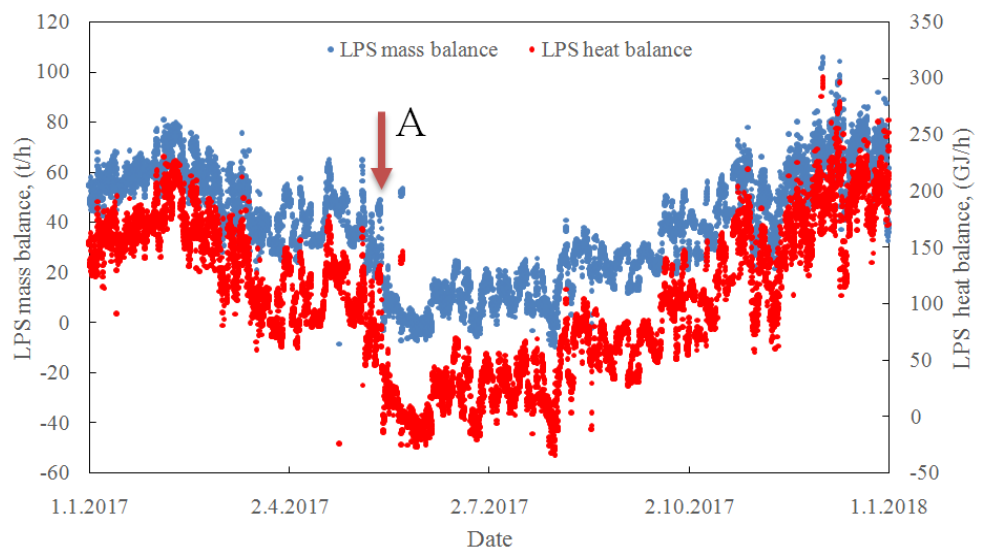
Figure 6. A difference between the amount of steam supplied and consumed within the LPS network during the year 2017.